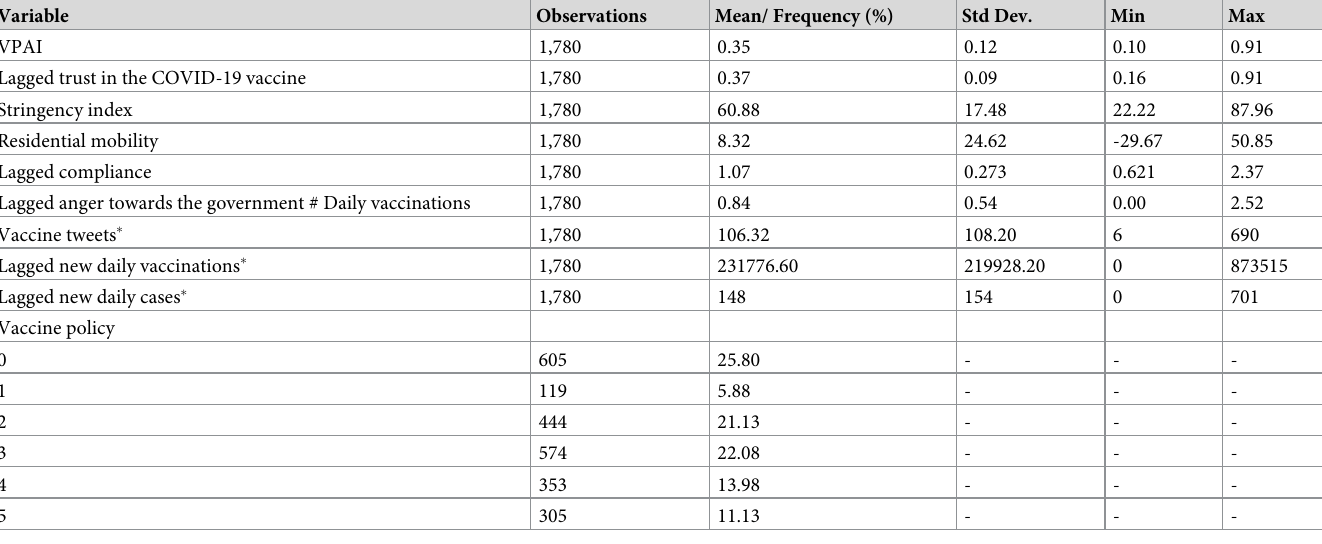
Table 2. Descriptive statistics of the variables included in the estimations of attitudes against the COVID-19